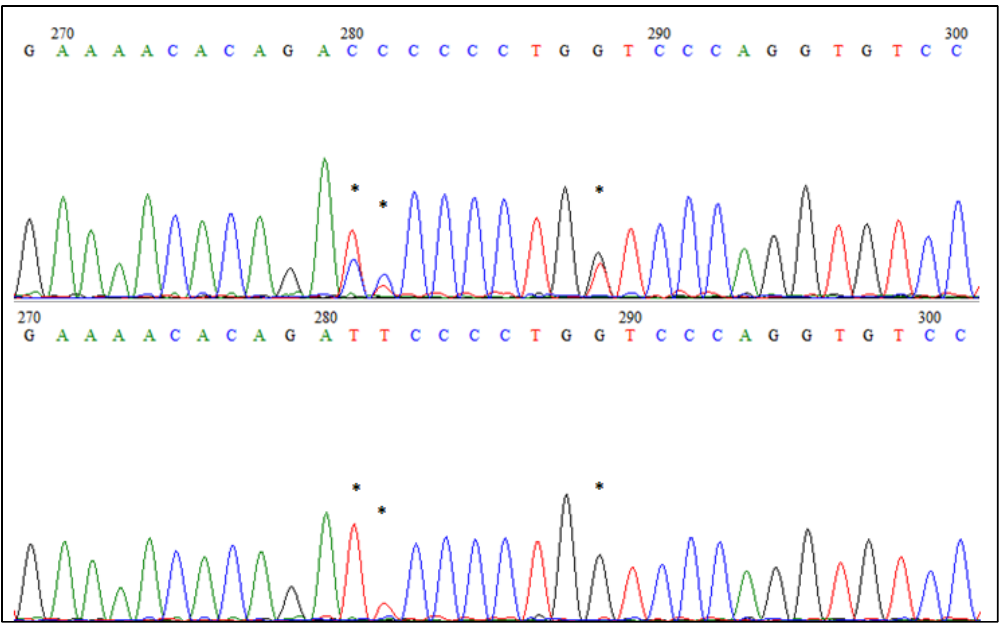
Figure 4. Chromatograms of fragments of the EDAR gene sequence after the Sanger sequencing. Asterisks indicate polymorphic SNPs, also identified by the GBS method.